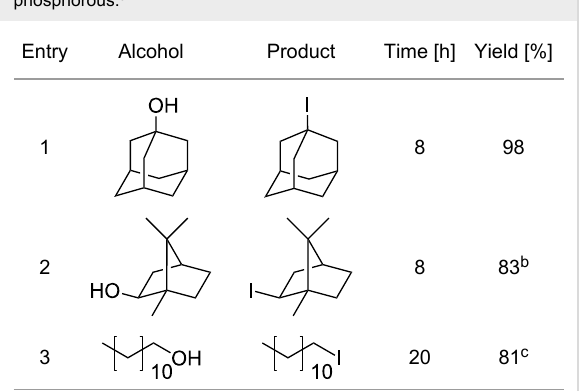
Table 3: Alcohols yielding alkyl iodides with hydriodic acid and red phosphorous. a